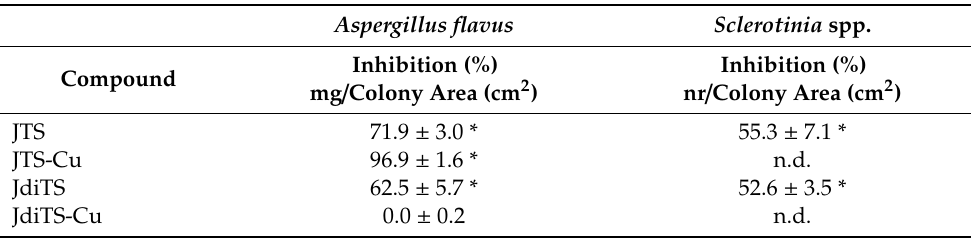
Figure 6. E ff ect of compounds on the mycotoxin production in two cereals pathogenic fungi. Toxins T-2 and HT-2 were quantified in F. sporotrichioides cultures exposed to increasing concentration (from 1 to 25 µ M) of J, JTS, Jdi and JdiTS compounds ( A ). Aflatoxins were quantified in A. flavus cultures exposed to increasing concentration (from 25 to 100 µ M) of all the compounds ( B ). Values are reported as inhibition percentage as compared to the control (DMSO amended cultures) ± S.D. Asterisks or di ff erent letters indicate statistically significant di ff erences ( p < 0.05). Table 3. E ff ect of compounds on sclerotia biogenesis. Sclerotia biomass ( A. flavus ) or number ( Sclerotinia spp.) was determined in cultures exposed to 100 µ M concentration of compounds. Values are reported as inhibition percentage as compared to the control (DMSO amended cultures) ± S.D. Asterisks indicate statistically significant di ff erences ( p <